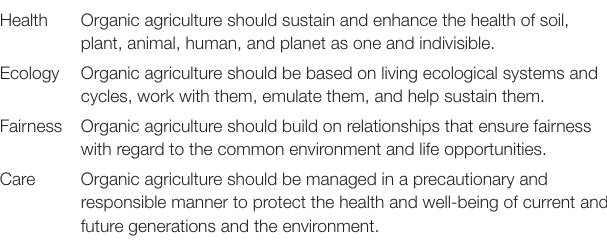
TABLE 1 | The four principles of organic agriculture by the IFOAM (Luttikholt, 2007).